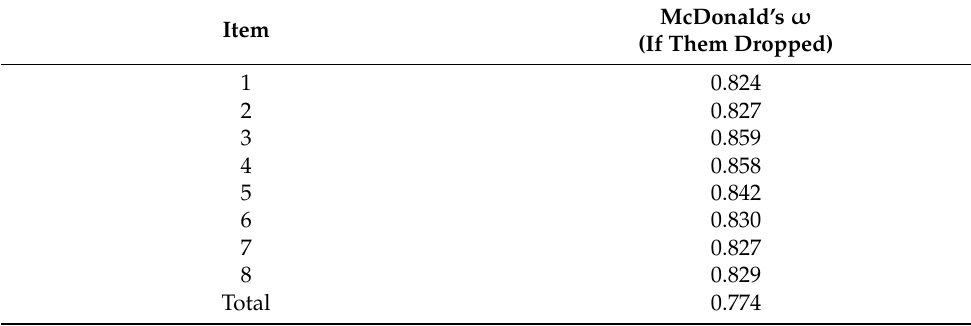
Table 3. Item reliability analysis of the PrEP adherence questionnaire.